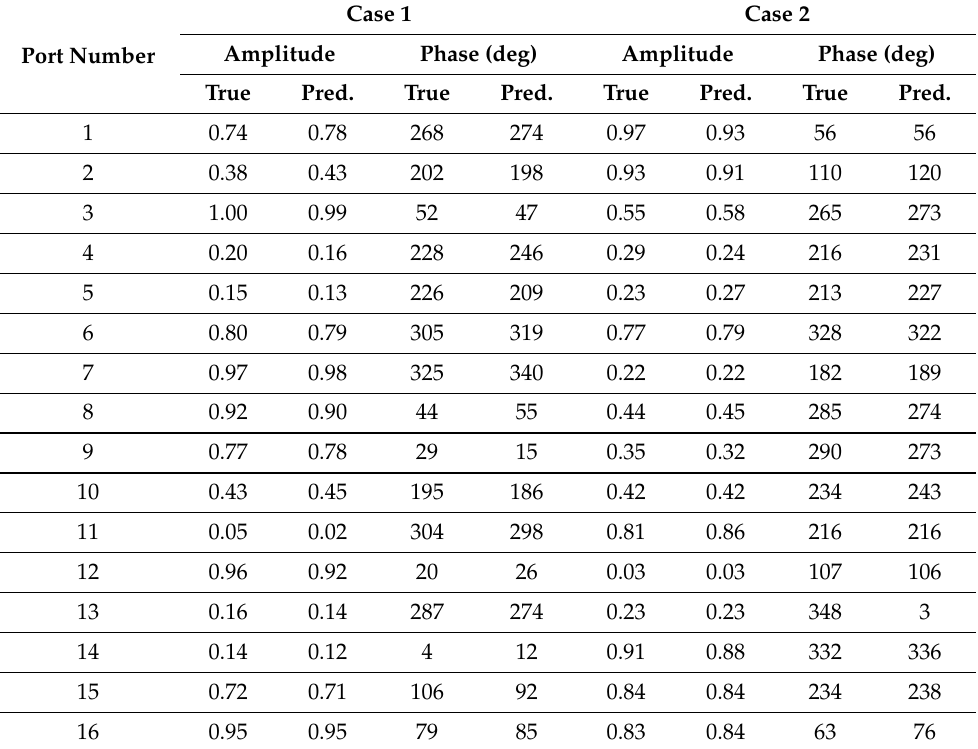
Table 7. Comparison between true values and predicted values of cases 1 and 2 applied to regression trained